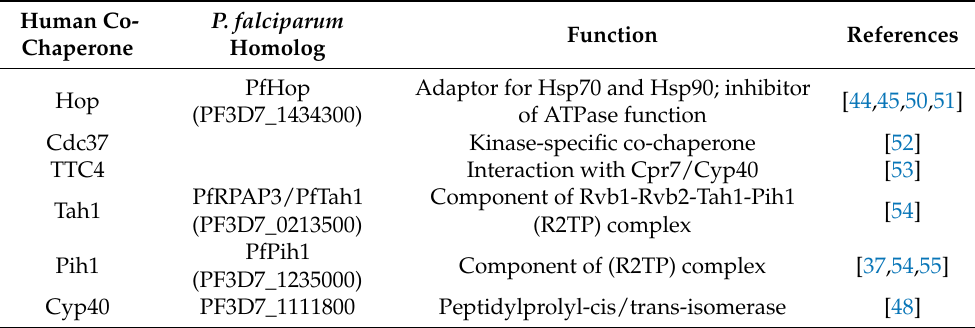
Table 1. Hsp90 proteins from Plasmodium falciparum and Homo sapiens . Human